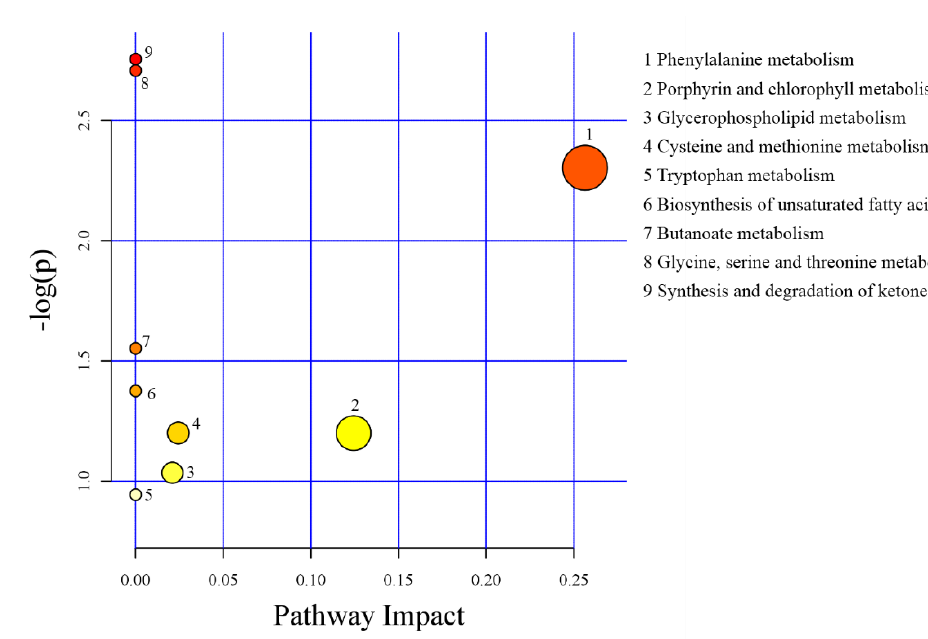
Figure 3. Pathway analysis of di ff erential metabolites in serum between CON and FCSM groups using MetaboAnalyst 3.0. CON, no fermented cottonseed meal in diet; FCSM, 6% fermented cottonseed meal in diet. The colour of the circles from white to yellow to red denotes incremental fold change ( − log(p)). The size of the circles from small to large indicates an increment of pathway impact.